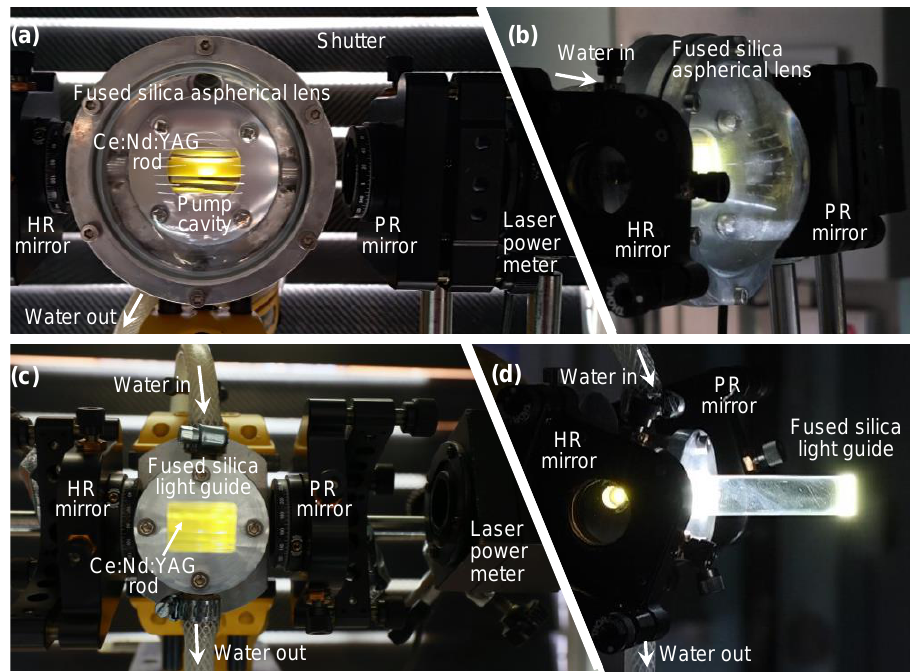
Figure 4. Photographs of the front view ( a , c ) and side view ( b , d ) of the Ce:Nd:YAG solar laser heads using the fused silica aspherical lens ( a , b ) and the fused silica light guide ( c , d ). PR: partial reflection; HR: high reflection.